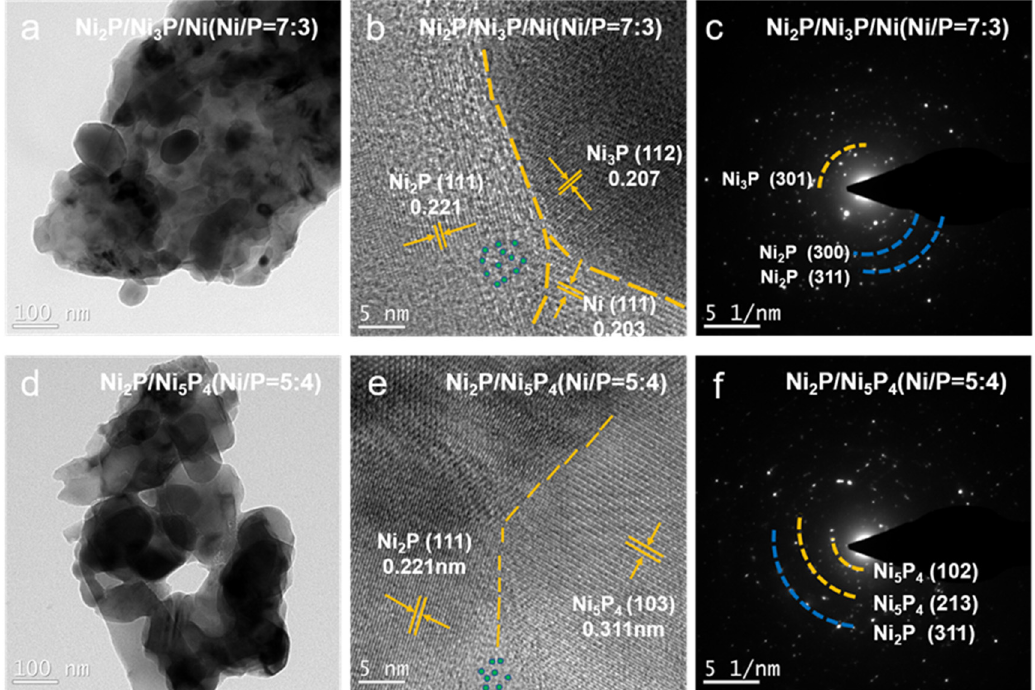
Figure 3. TEM images of the prepared sample. ( a – c ) The TEM, HRTEM, and SAED images of Ni 2 P/Ni 3 P/Ni (Ni/P = 7:3). ( d – f ) The TEM, HRTEM, and SAED images of Ni 2 P/Ni 5 P 4 (Ni/P = 5:4).